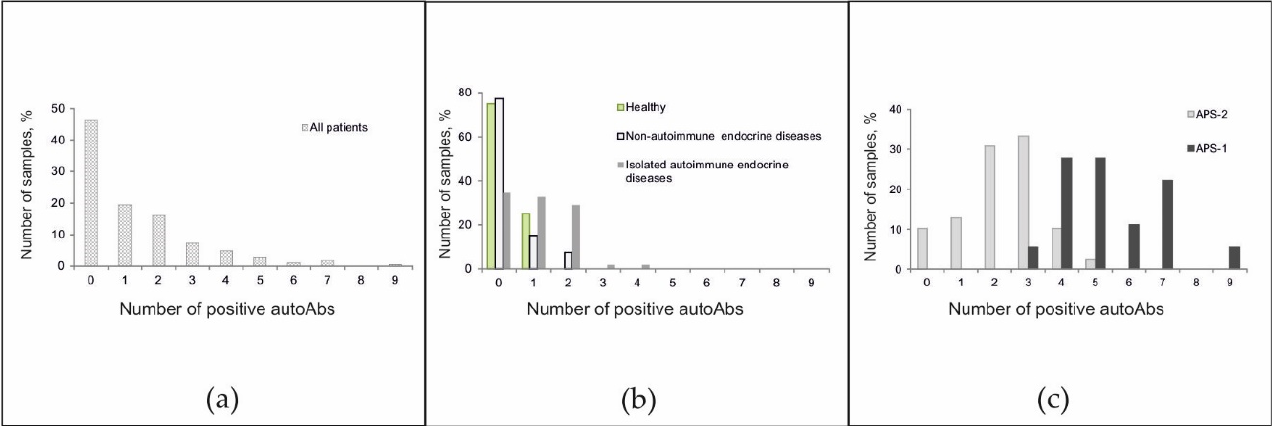
Figure 4. Frequencies of positive autoantibodies among ( a ) all patients; ( b ) healthy donors and patients without autoimmune polyendocrine syndromes; and ( c ) patients with autoimmune polyendocrine syndromes. Additionally, we investigated the distribution of the frequency of detected organ-specific autoantibodies associated with T1D and AITDs in patients with isolated disease and in APS patients. At least one of three autoantibodies (GAD-65, IA2, or ICA) was detected in 14.3% of healthy patients ( n = 28), in 33.3% of APS-2 patients without a T1D diagnosis ( n = 25), in 30.0% of patients with T1D ( n = 20), in 42.9% of APS-2 patients with a diagnosis of T1D ( n = 14), and in 35.3% of APS-1 patients without a diagnosis of T1D ( n = 17) (Figure 5a). In addition, two autoantibodies were detected simultaneously in patients with isolated T1D (15.0%), APS-2 patients with a diagnosis of T1D (14.3%), and patients with APS-1 without T1D (29.4%). Among all patients, only one patient with APS-1 and diagnosed with T1D (#115) was identified to be simultaneously positive for all three autoantibodies associated with T1D (data not shown).